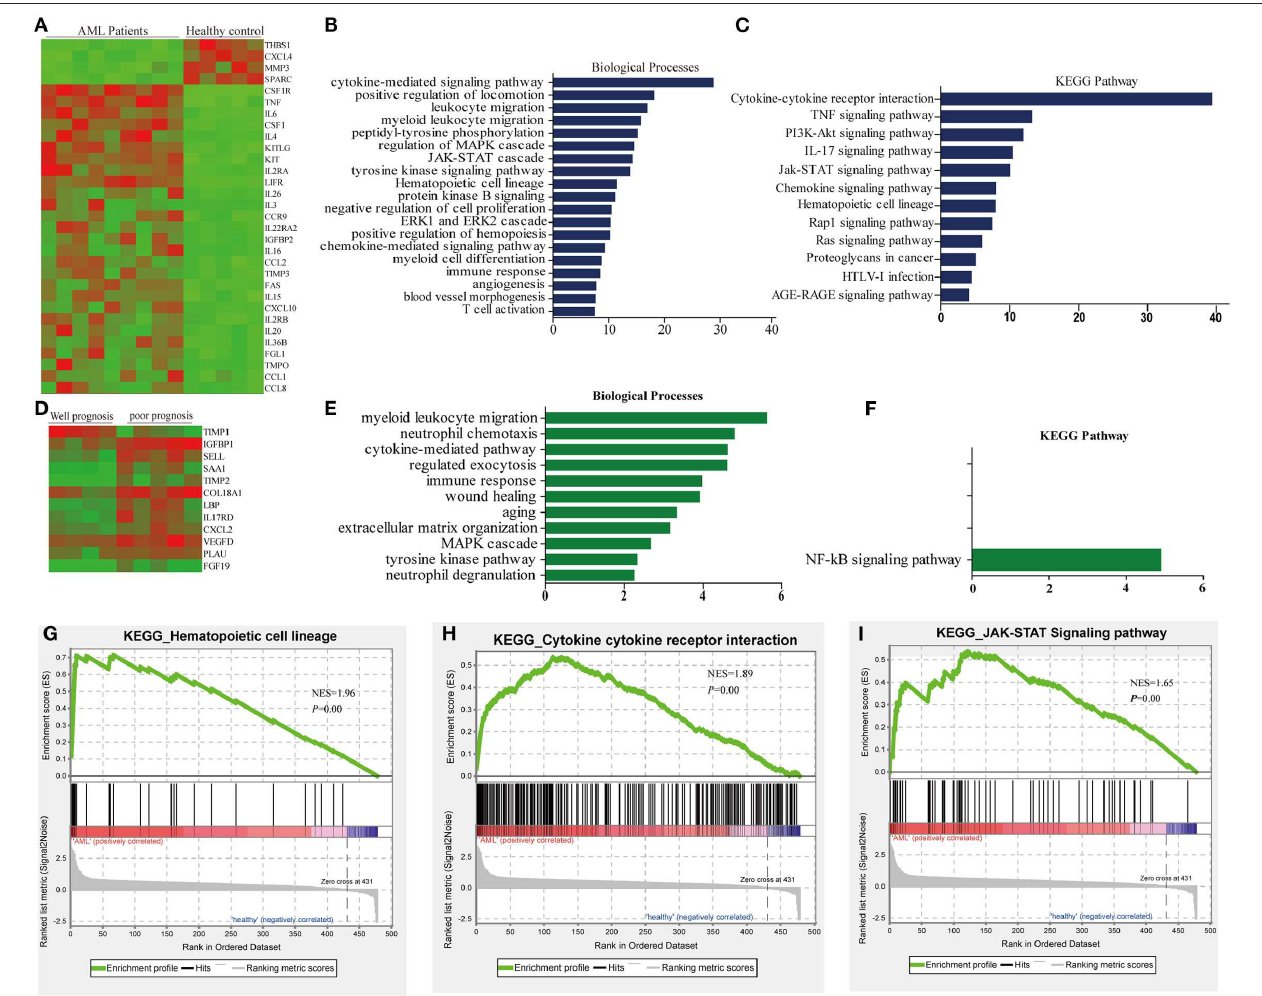
FIGURE 1 | Differential abundance of serum cytokines in AML patients and normal controls. (A) Hierarchical clustering analysis of cytokine profiles based on the top 31 genes in AML patients and healthy controls. (B) Biological process revealed the significant association of the genes with different expression in each group, column length: –log(P). (C) Heatmap of Kyoto Encyclopedia of Gene and Genomes (KEGG) enriched terms colored by P -values. (D) Hierarchical clustering analysis of cytokine profiles based on the top 12 genes in AML patients. (E) Biological process enriched terms colored by P -value, column length: –log(P). (F) KEGG enriched terms colored by P -values. (G–I) The top three enriched pathway in AML patients and healthy control analyzed by gene set enrichment analysis